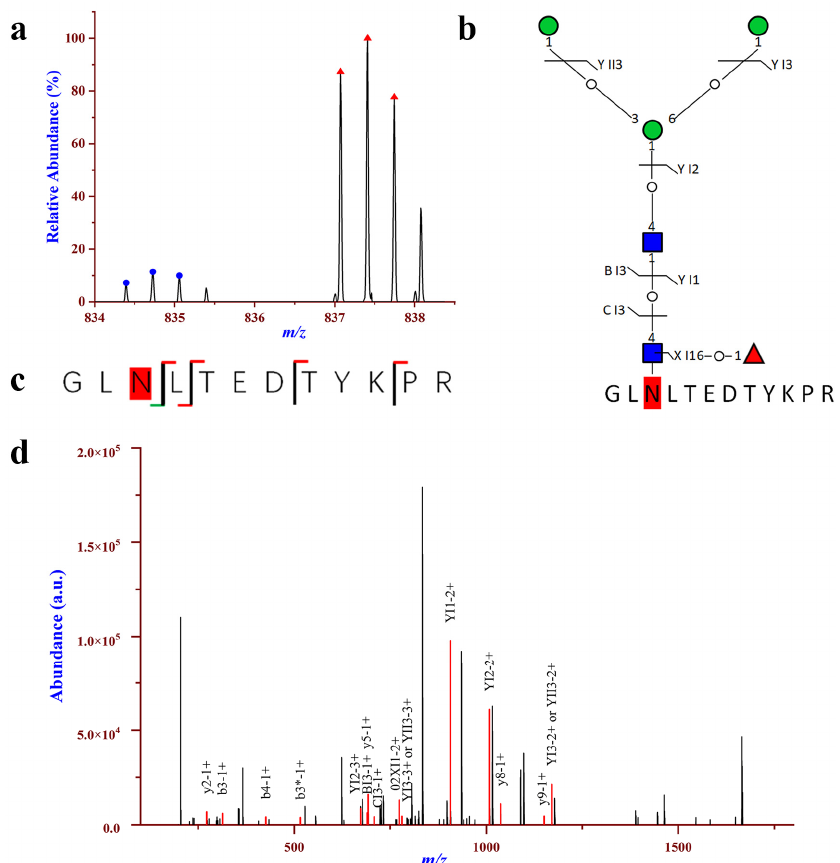
Figure 4. Up-regulation of intact N-glycopeptide GLNLTEDTYKPR_N2H3F1S0 in urinary EVs from patients with HCC relative to NC; the N-glycosite is N398 on Galectin-3-binding protein (LG3BP_HUMAN, Q08380). ( a ) Paired precursor ions. ( b , c ) N-glycan and peptide backbone graphical fragmentation maps annotated with the matched fragment ions. ( d ) The MS/MS spectrum with the matched fragment ions.